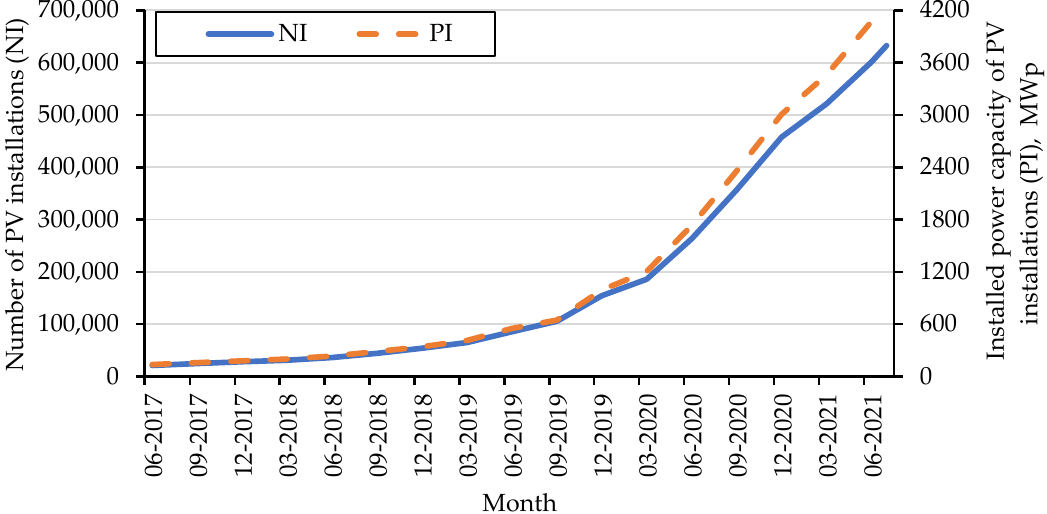
Figure 2. Number of PV installations and installed power capacity of PV installation in Poland. Authors’ study based on [30].